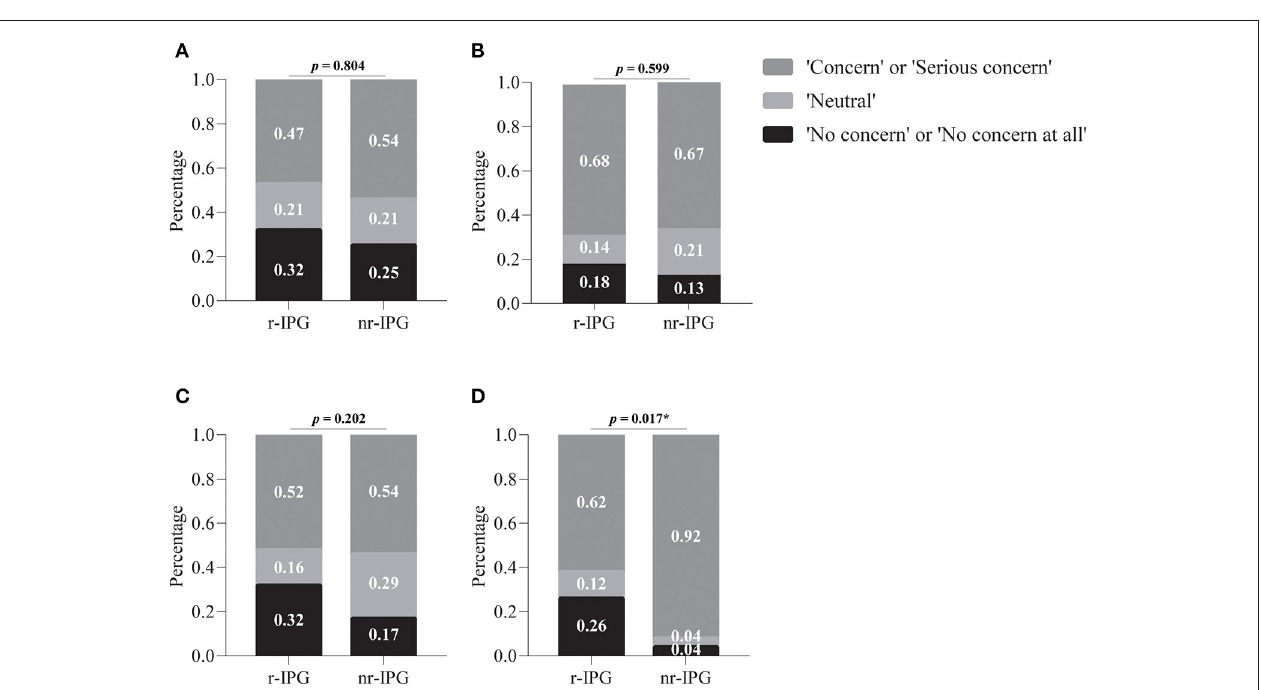
FIGURE 2 | Factors influencing patients’ choice between a rechargeable (r-IPG) and non-rechargeable (nr-IPG) implanted pulse generator. (A) Battery size; (B) the need for further surgery to replace the battery; (C) the need for recharging the battery, and (D) economic issues. Patients’ attitudes toward these factors were divided into five levels in the questionnaire: “No concern at all,” “No concern,” “Neutral,” “Concern,” and “Serious concern.” The choices of “Concern” and “Serious concern,” as well as “No concern” and “No concern at all” were merged for data analysis. Data are presented as percentages. * p -value < 0.05 was considered statistically